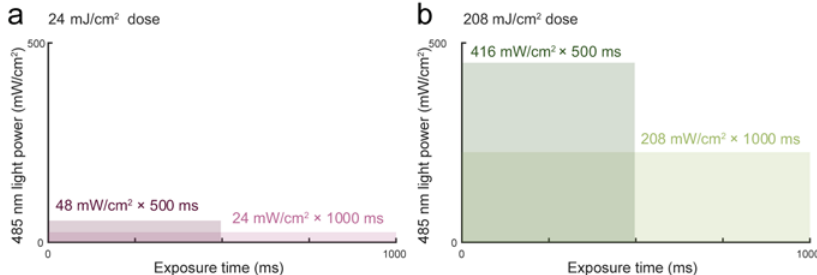
Figure 1. Blue light doses used in the experiment. Resulting blue light doses 0, 24 ( a ) and 208 ( b ) mJ / cm 2 were achieved by the combination of time exposition and light intensity. The intensity of fluorescence light is shown in mW / cm 2 . Exposure time was 500 and 1000 ms, respectively.